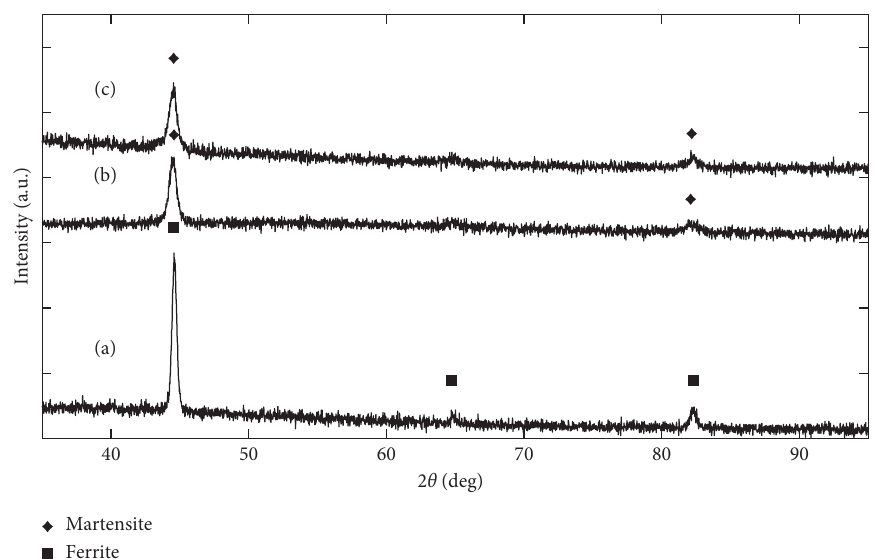
Figure 4: XRD patterns of samples surface for different conditions: (a) RAW, (b) CQT, and (c) LQ.